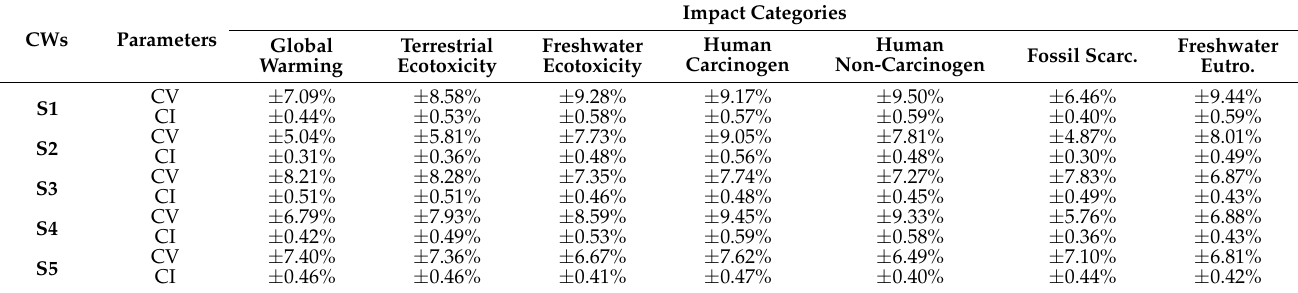
Table 5. Results of uncertainty analysis of inventory components under LCA application of CW.